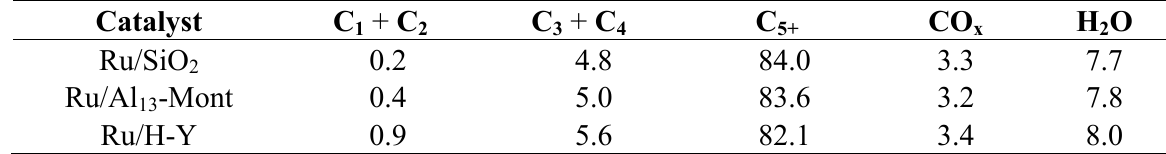
Table 4. Product yields over various catalysts in the hydrotreatment of waste cooking oil a .